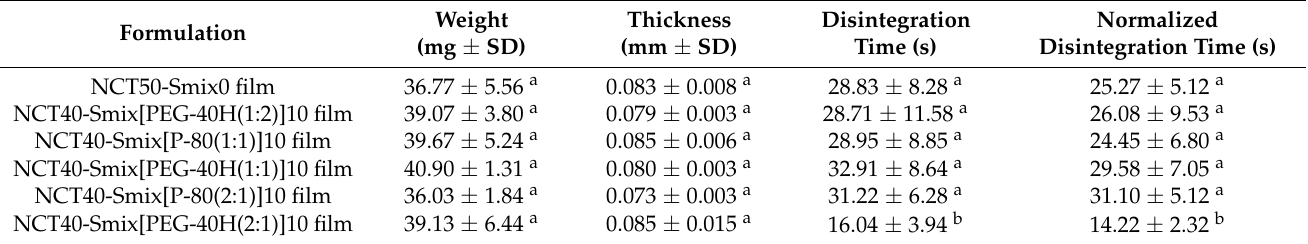
Table 2. Weight, thickness, and in vitro disintegration time of the selected NCT-ME fast-dissolving